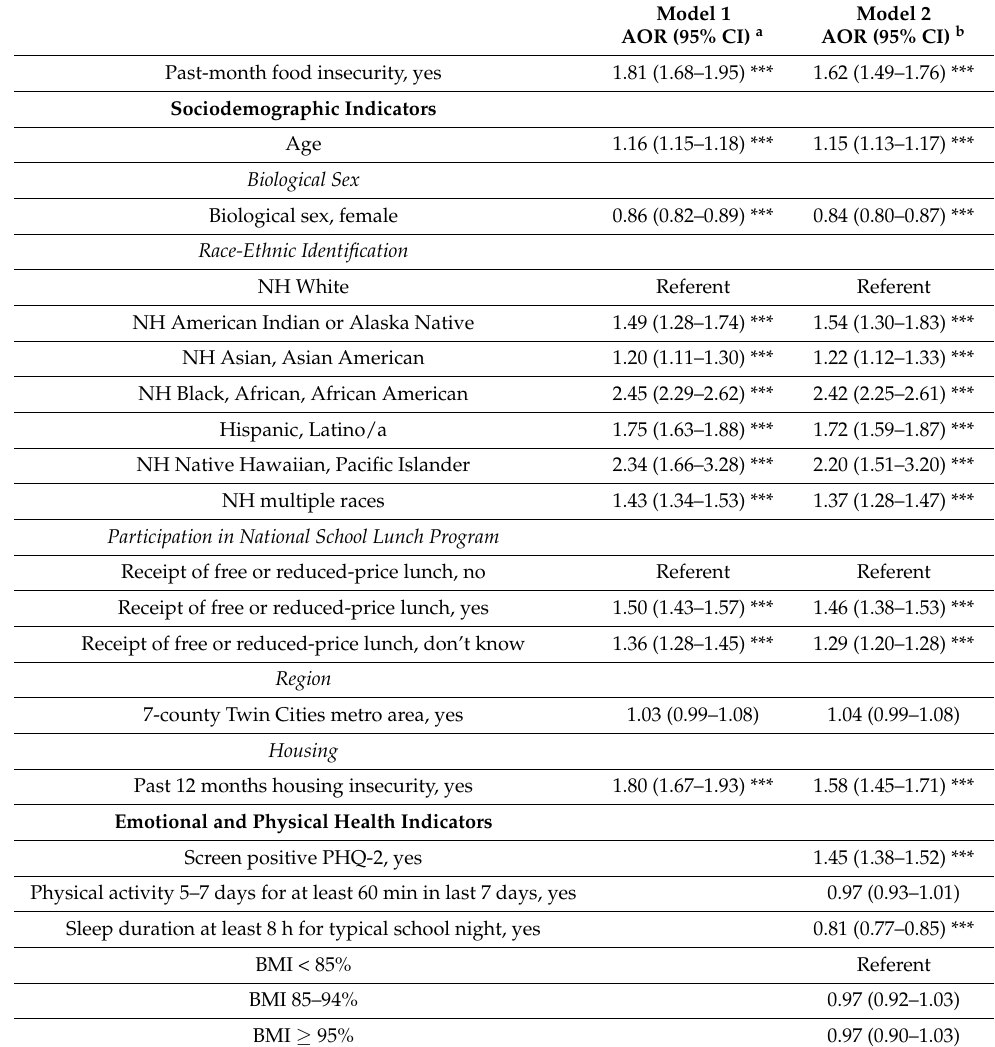
Table 5. Past-Month Food Insecurity and Student Consumption of Fast Food Four or More Times, Past 7